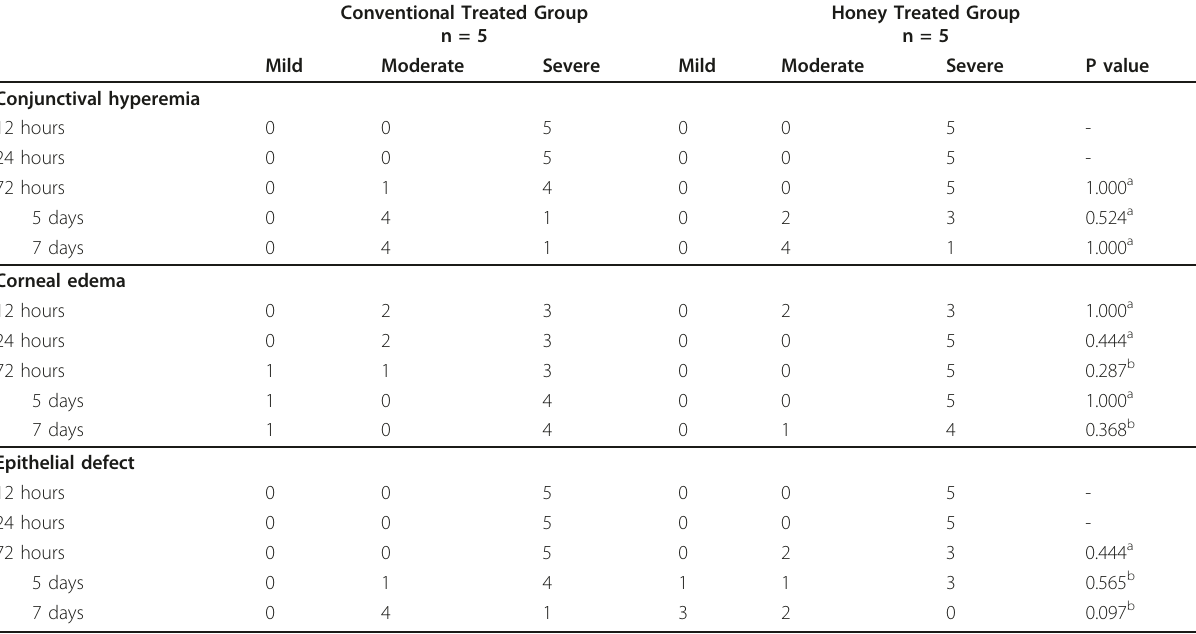
Table 3 Clinical inflammatory features of alkali chemical injury on rabbit ’ s cornea between conventional treated and honey treated group Conventional Treated Group n =